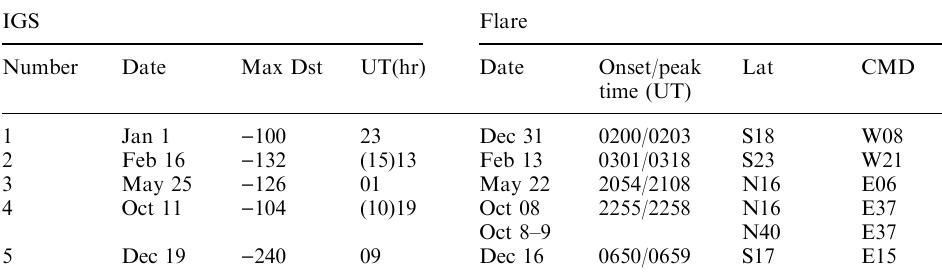
Table 1. Intense geomagnetic storms in 1980 and associated